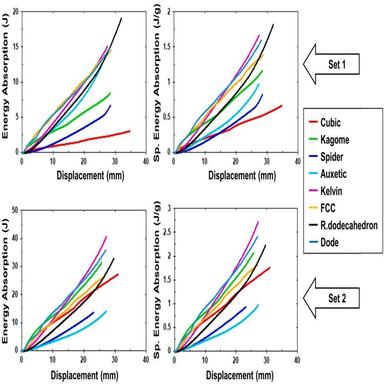
Comparison of the energy absorption capabilities among different lattice structures with constant diameter of the struts (set 1) and constant relative density (set 2).